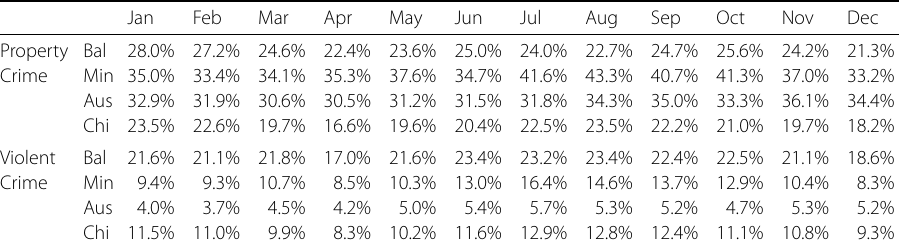
Table 2 Crime occurrence monthly density for the four cities in 2020: Baltimore (Bal), Minneapolis (Min), Austin (Aus) and Chicago (Chi) Jan Feb Mar Apr May Jun Jul Aug Sep Oct Nov Dec Property